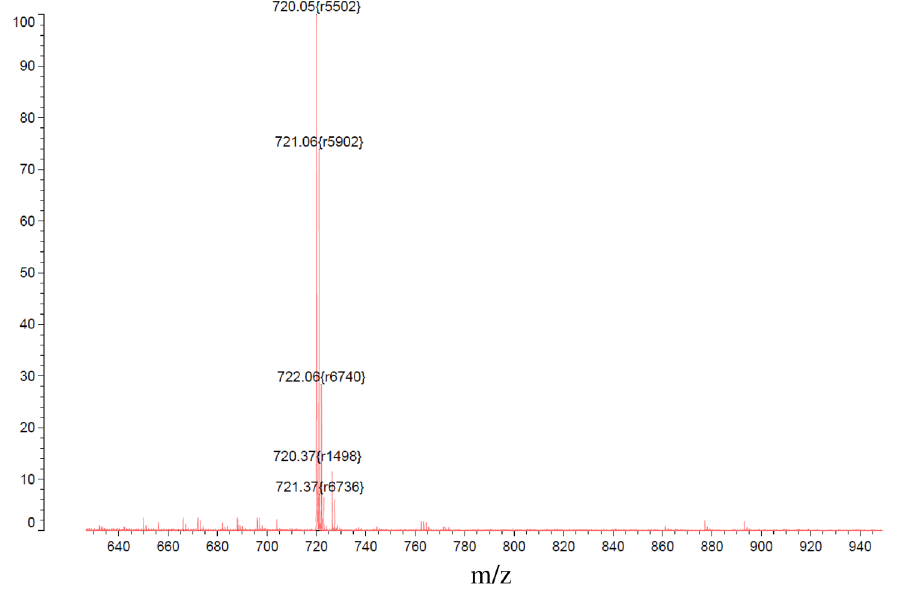
Figure 2. MALDI mass spectrum of C 60